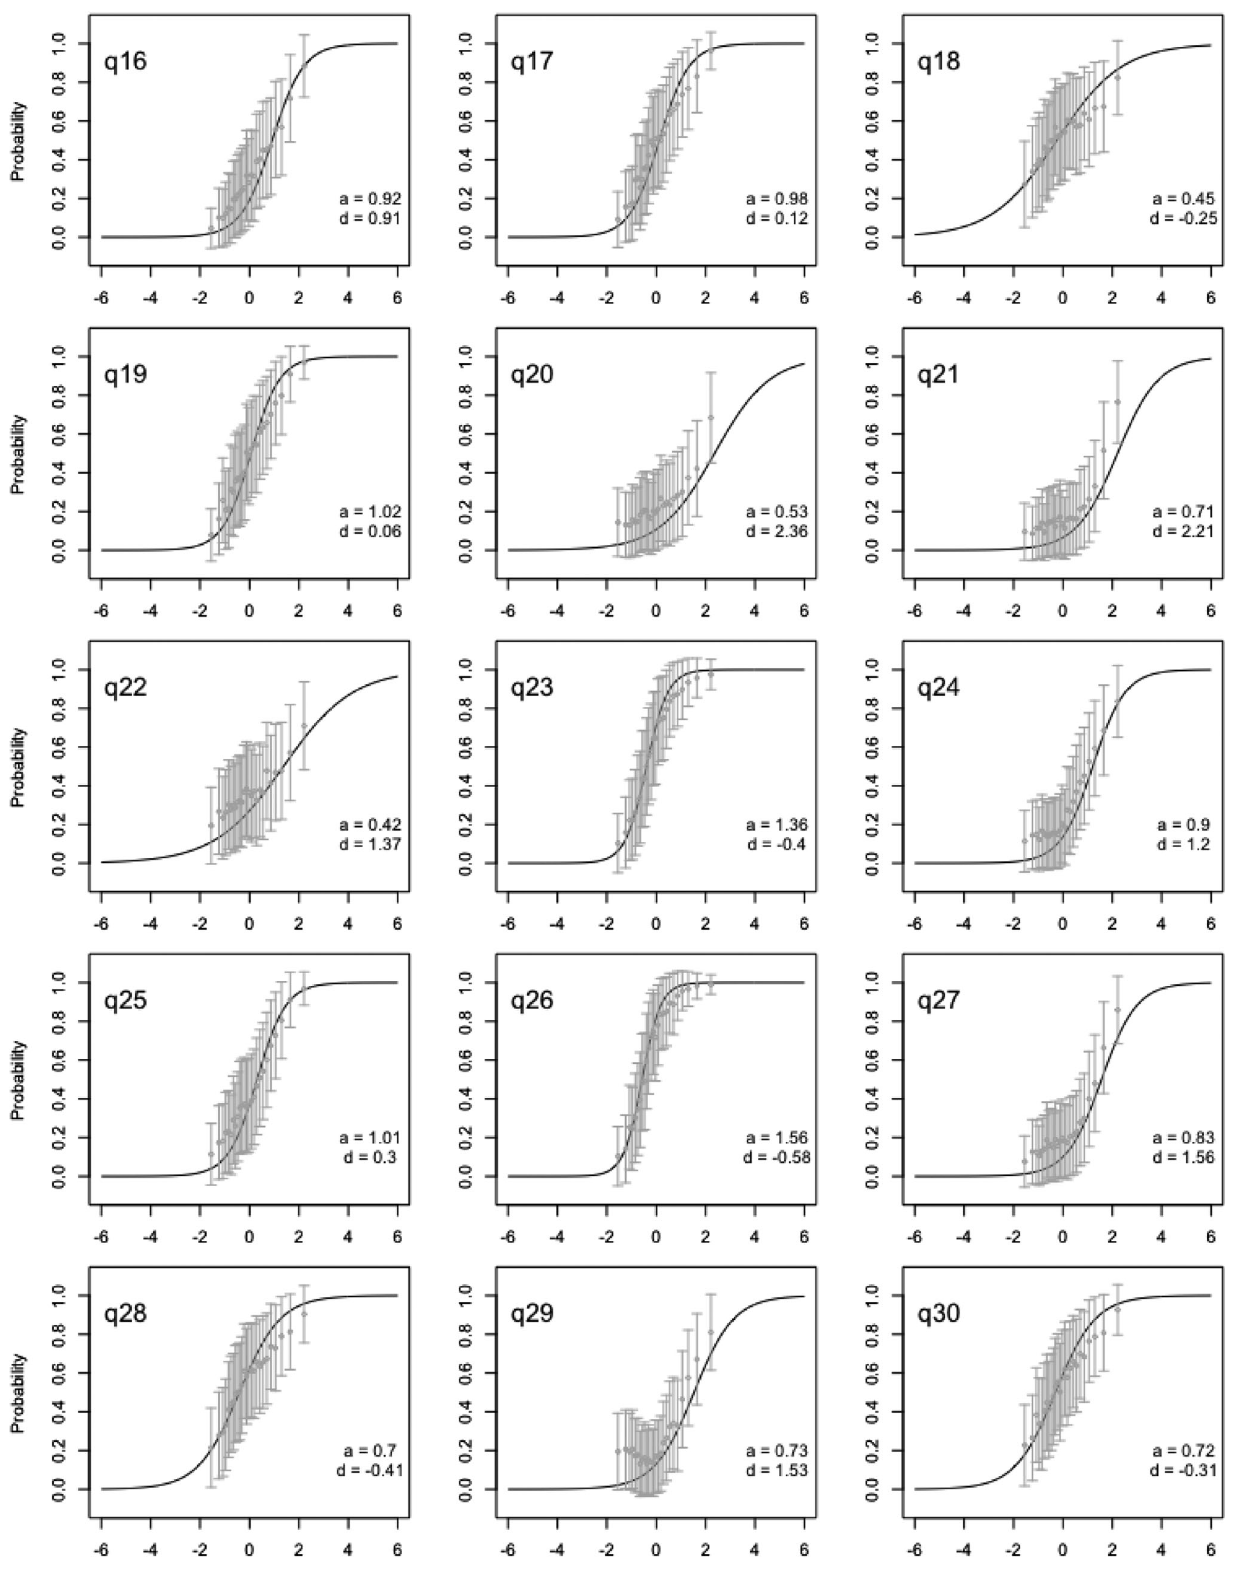
FIG. 14. Item characteristic curves for the item 16 – 30 on the CSEM. The gray error bars represent one standard deviation, from top to bottom, in the student responses. The horizontal axis is student latent